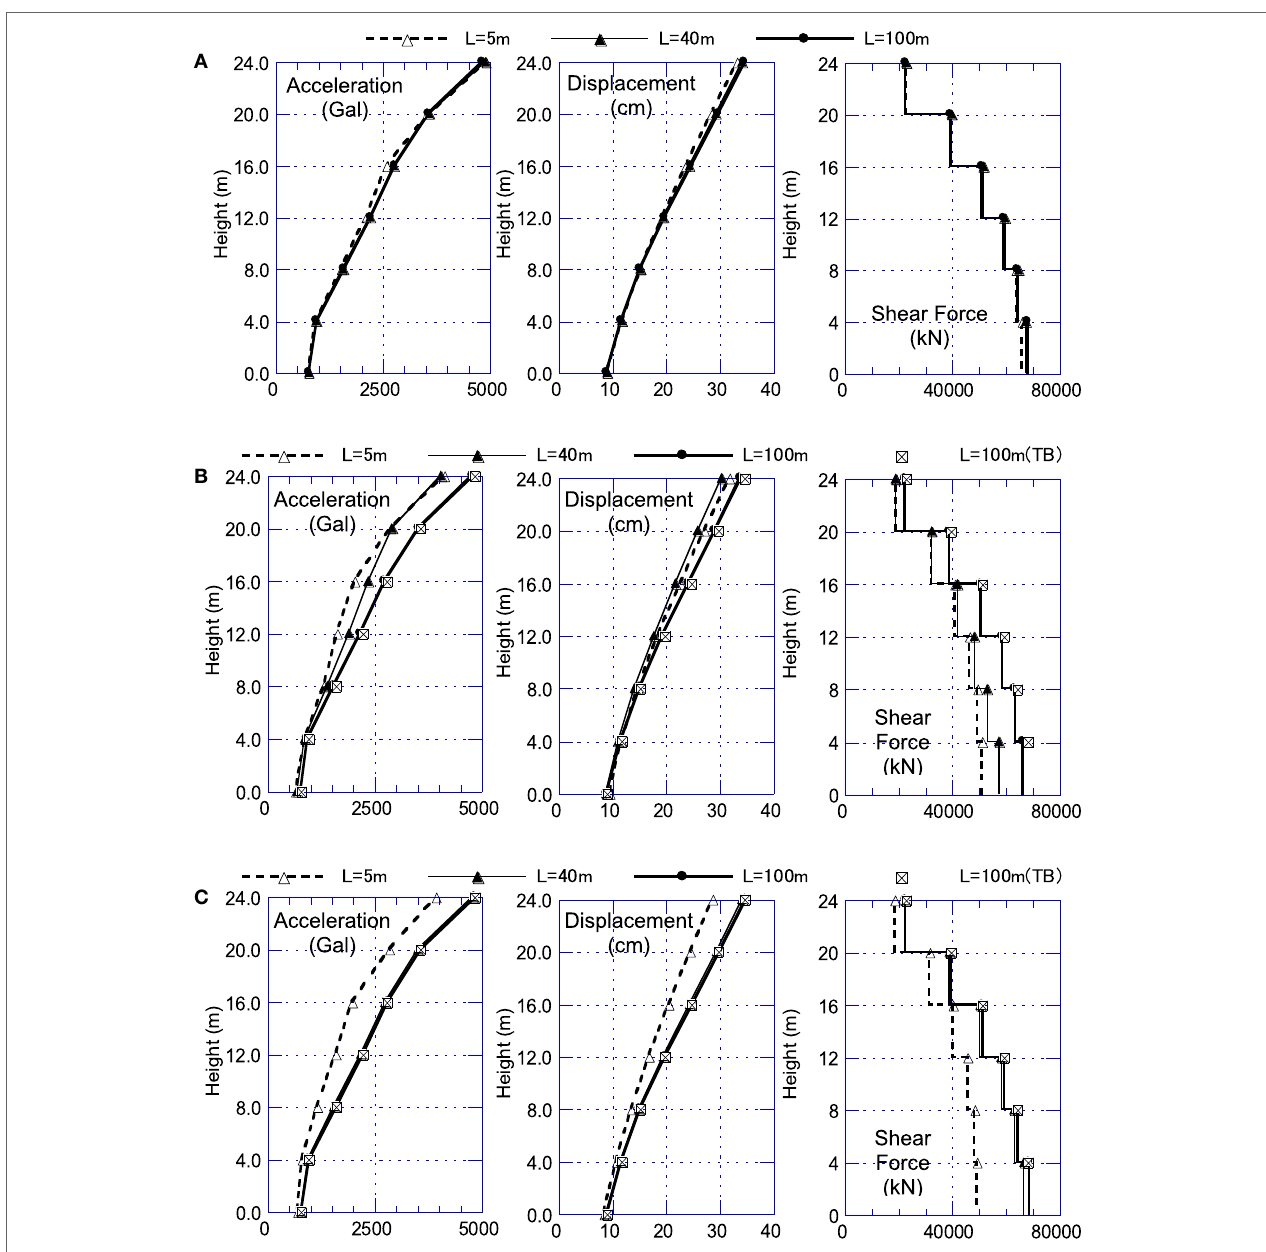
FigUre 14 | Maximum response of building for X excitation . (a) TB. (B) VB without EF. (c) VB with